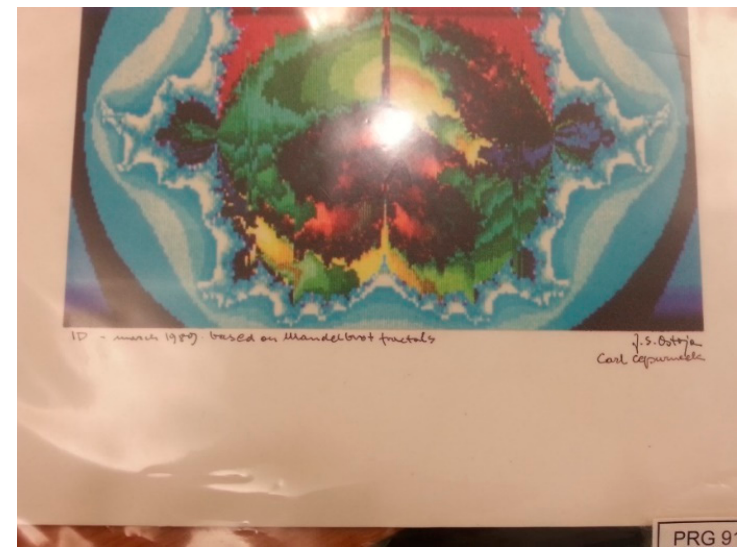
Figure 21. Figure 21. Close-up of “Id”, co-signed by Ostoja and Cepurneek, and dated March 1989. SLSA: PRG919/21/835. Image courtesy Melanie Swalwell. Published with permission of SLSA.